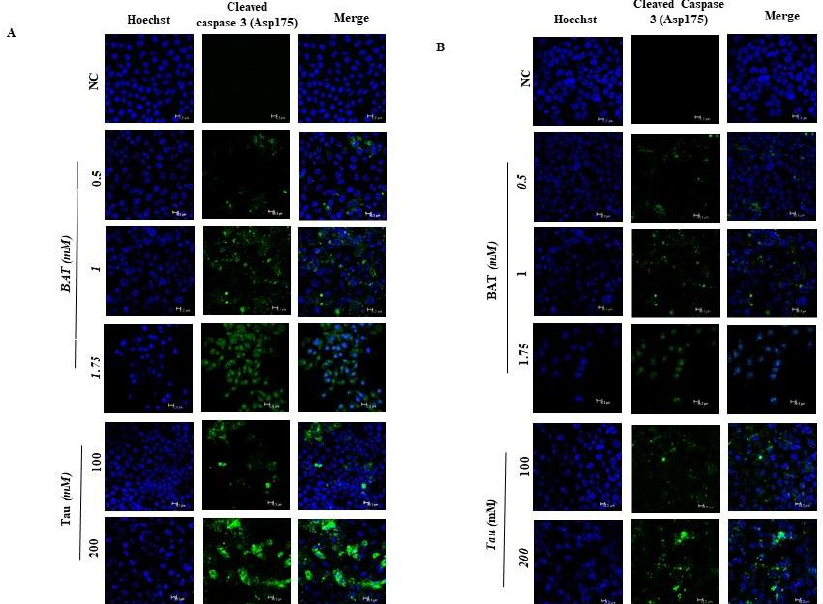
Figure 7. Both BAT and Tau stimulate the mitochondrial apoptotic pathway in cancer cells: ( A ) immunofluorescence staining for cleaved caspase 3 (Asp175) in RKO cells after treatment with (0.5–1.75 mM) BAT or (100–200 mM) Tau for 48 h versus negative control (NC). Hoechst was used to stain the cell nuclei (magnification ×400); ( B ) immunofluorescence staining for cleaved caspase 3 (Asp175) in MDA-MB-468 cells after treatment with (0.5–1.75 mM) BAT or (100–200 mM) Tau for 48 h versus negative control (NC). Hoechst was used to stain the cell nuclei (magnification ×400). Quantification and statistical analysis are shown in Figure S6.